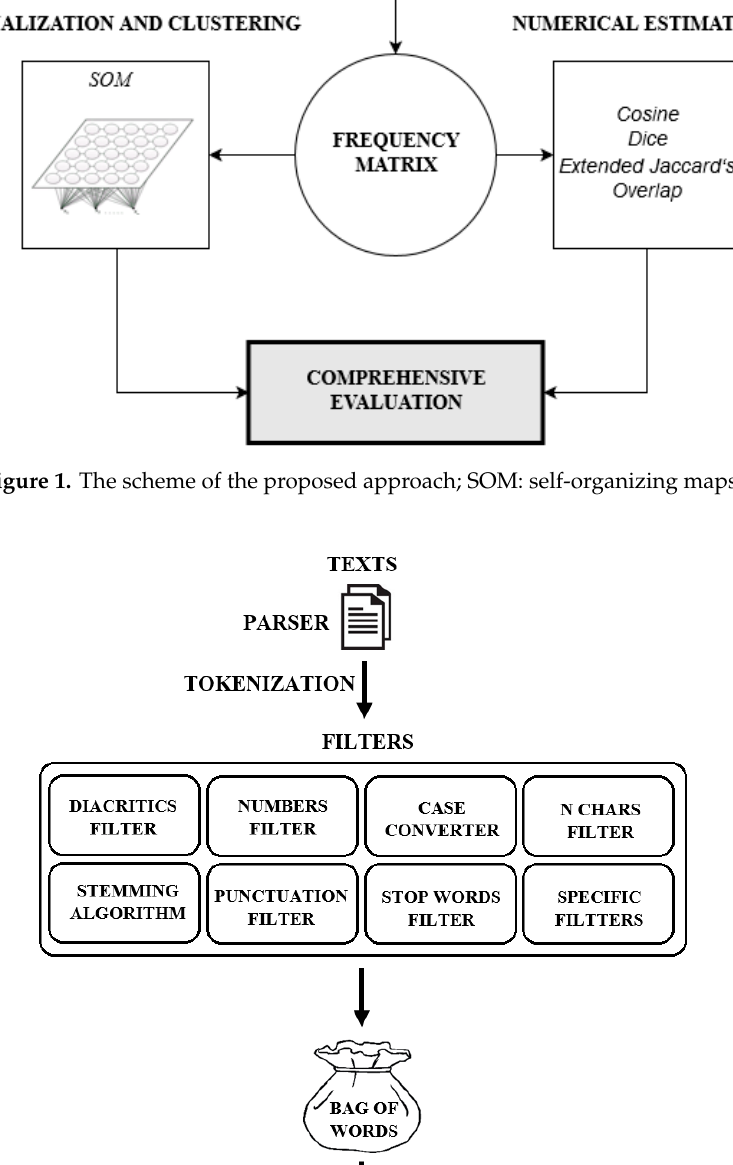
Figure 2. The process of creation of frequency matrix.